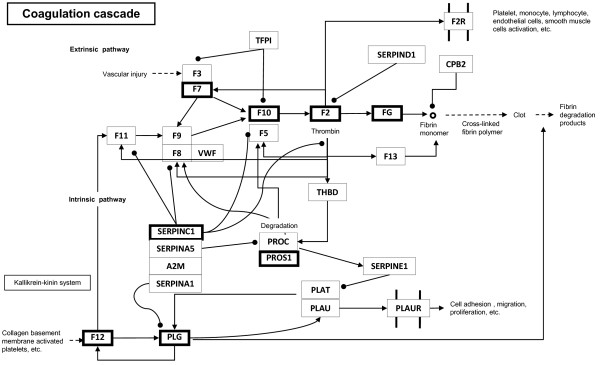
Genes involved in the coagulation process that are regulated by the diet composition (FD/VD). The mammalian coagulation cascade pathway is shown. Pathway information is adapted from the KEGG database [74]. Genes significantly stimulated by the use of the VD are indicated in bold in boxes (serpinc1, pros1, plg, f12, f7, f10, fgb (fg) and fgg (fg)).